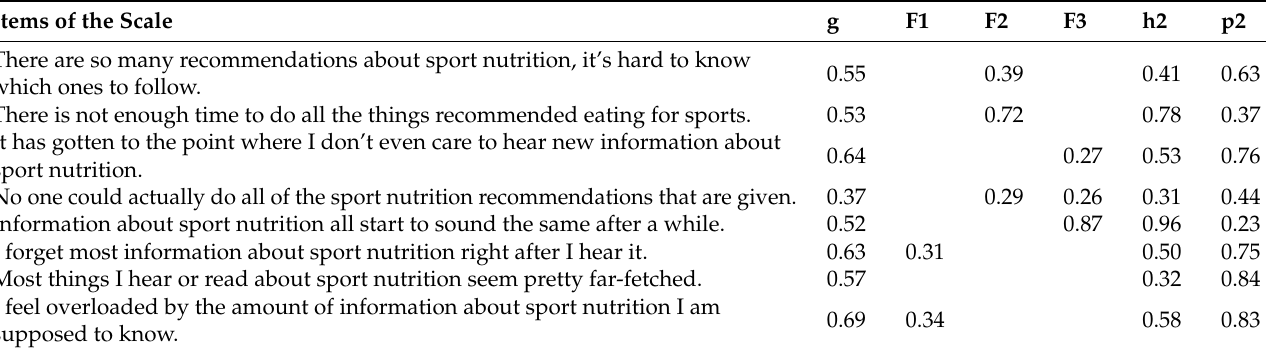
Table 10. Results of confirmatory factor loading analysis by Schmid–Leiman